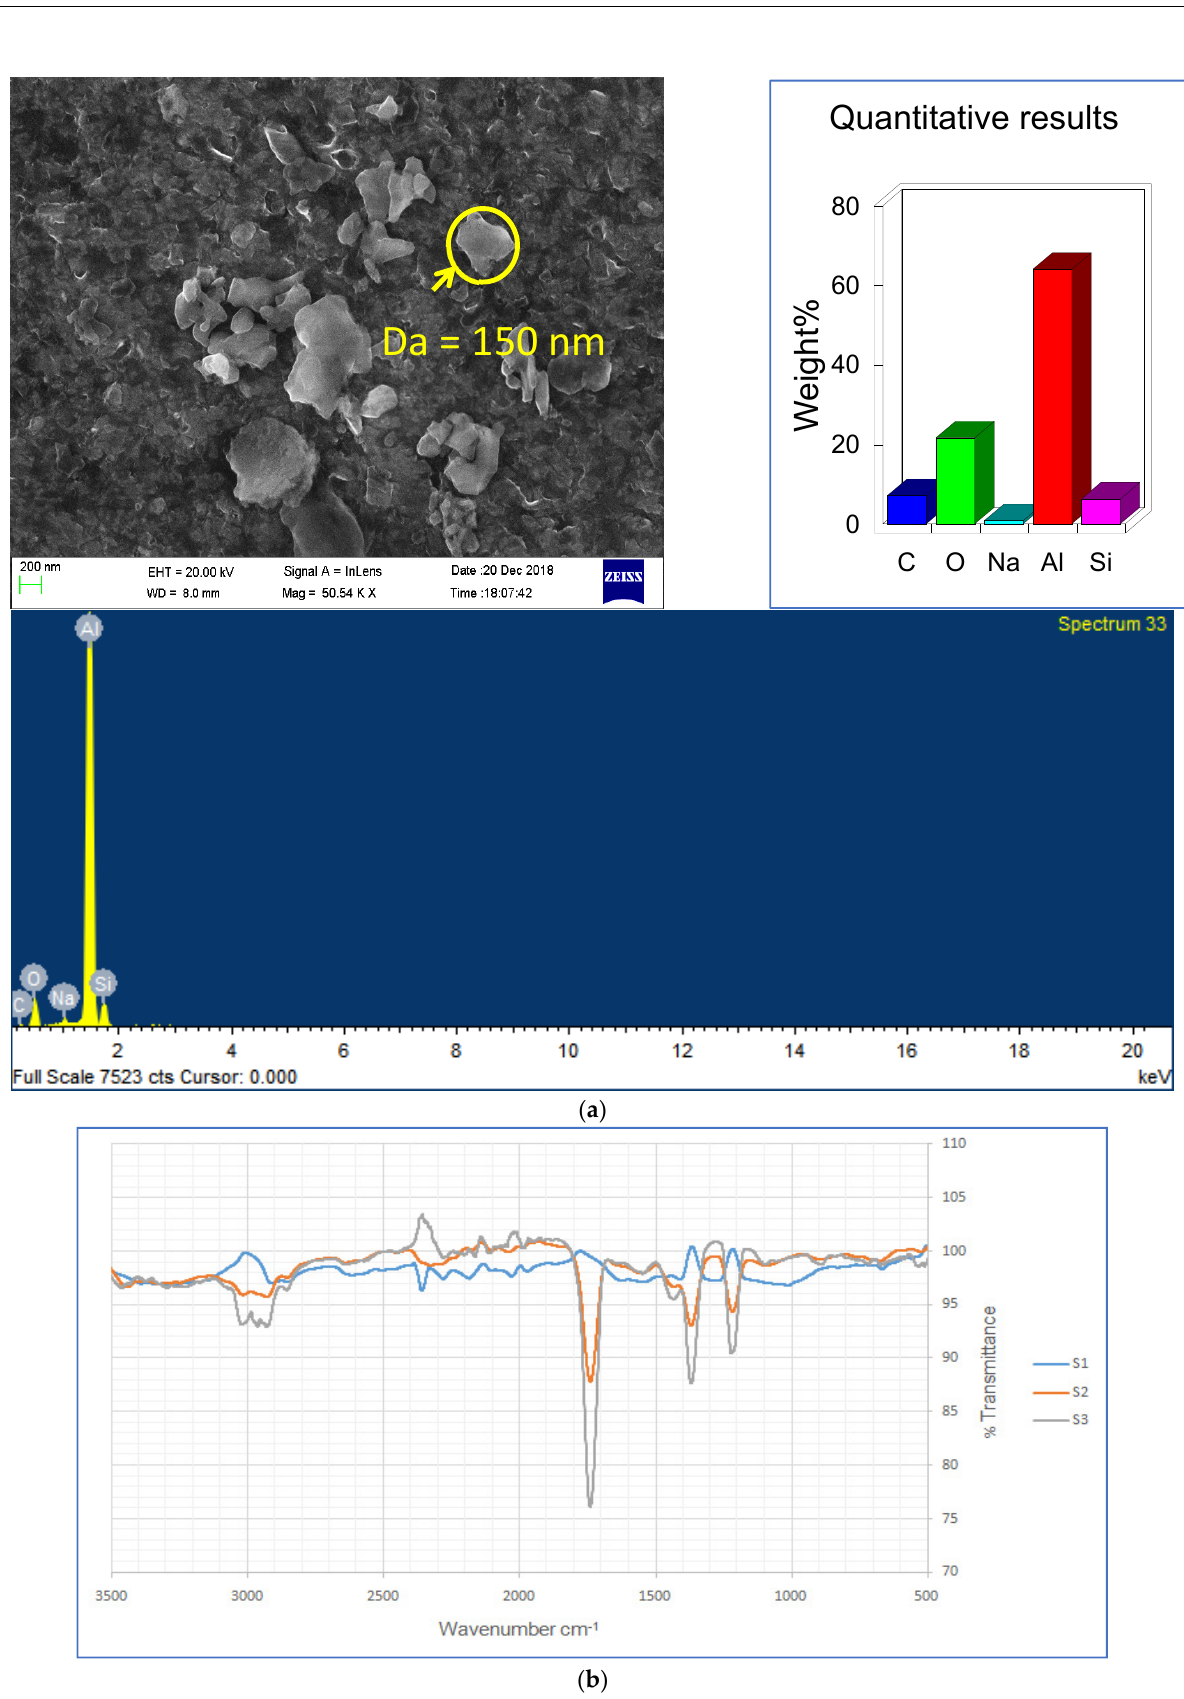
Figure 1. ( a ) SEM with EDX of nano-SiC reinforced aluminum matrix composites. ( b ) IR spectroscopy analysis of nano-SiC reinforced aluminum matrix composites.